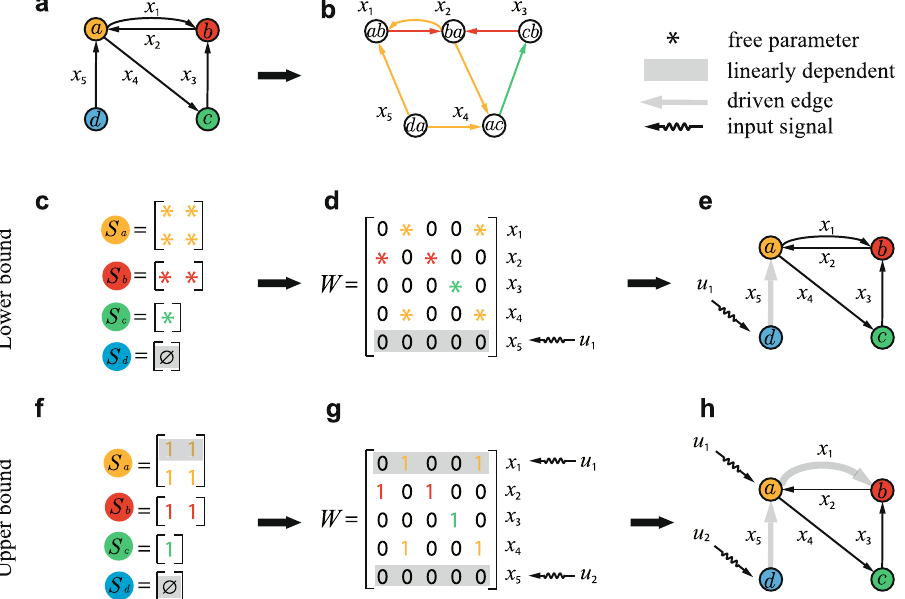
Figure 1. Control of general switchboard dynamics. ( a ) A directed network G with four nodes: a , b , c , and d , and five edges: x i ( i = 1, … , 5). ( b ) The line graph L ( G ) of the original directed network G . The colors of edges in L ( G ) correspond to those of the nodes in ( a ). ( c ) Structural switching matrices of the nodes in network G in ( a ). ( d ) Structural adjacency matrix W of the line graph L ( G ) in ( b ). ( e ) Driver node, driven edge and input signal for the structural adjacency matrix W . ( f ) Unweighted switching matrices of the nodes in network G in ( a ). ( g ) Unweighted adjacency matrix W of the line graph L ( G ) in ( b ). ( h ) Driver node, driven edge and input signals for the structural adjacency matrix W . Panels ( c – e ) and ( f – h ) correspond to the lower and upper bounds of controllability, respectively. The linearly dependent rows in W in ( d , g ) stem from independent rows in the switching matrices in ( c , f ), respectively. The edges associated with linearly dependent rows in W are the driven edges that should be controlled. The external input signals u should be imposed on the tail nodes of the driven